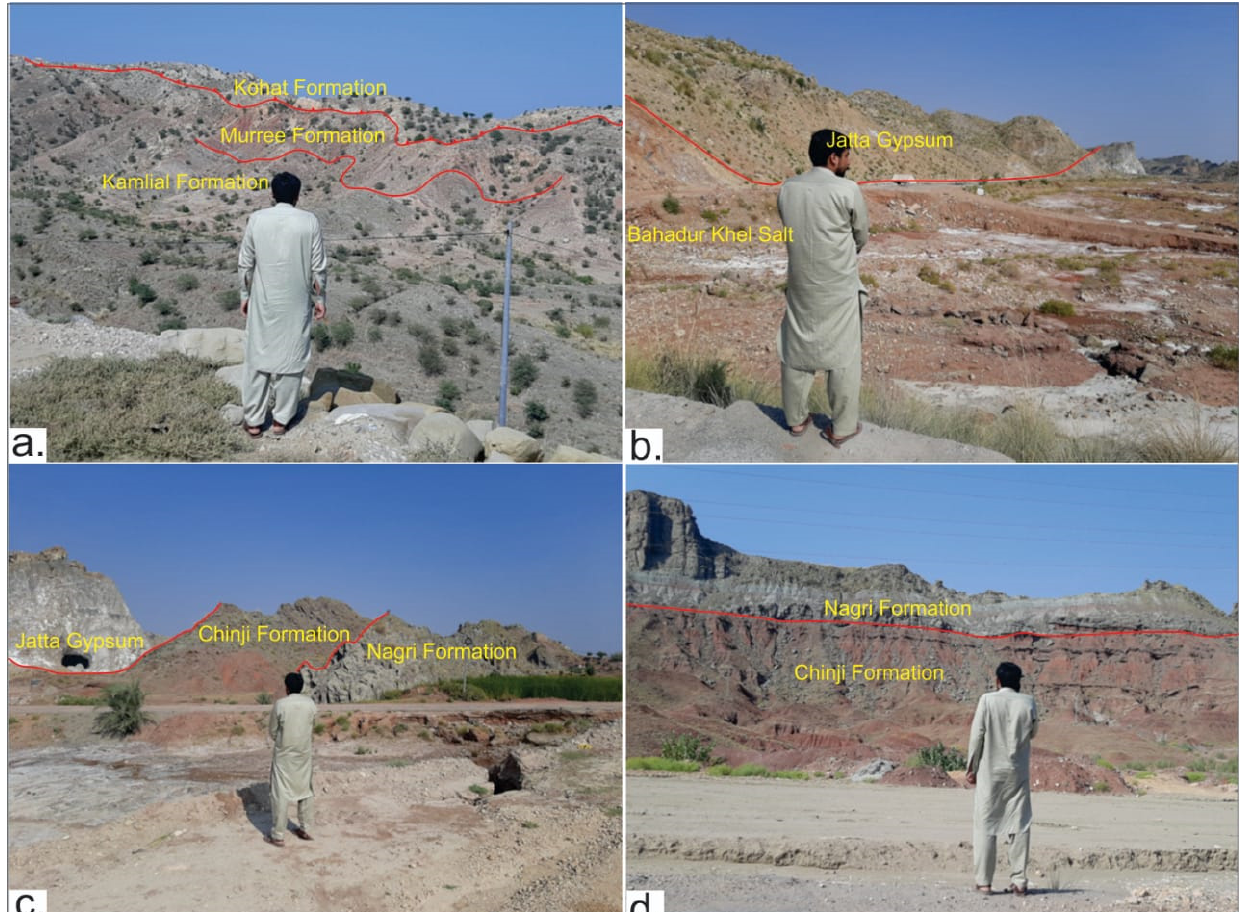
Figure 8. Field photographs of the lithostratigraphic units in the mapped area. ( a )—Looking north at contacts among the Kohat, Murree, and Kamlial formations. ( b )—Showing evaporites (Jatta Gypsum and Bahadurkheil Salt). ( c )—Looking northeast at contacts among the Jatta Gypsum, Chinji, and Nargi formations. ( d )—Looking north at the contact between the Chinji and Nagri formations (man’s height = 6 feet).